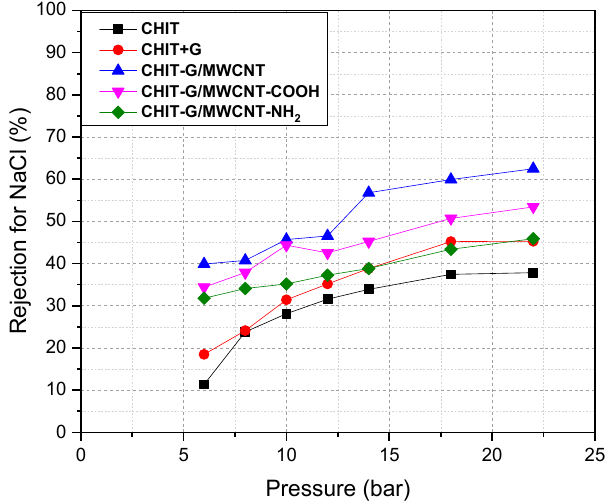
Figure 4. NaCl rejection at pH = 7 with membrane pressure.